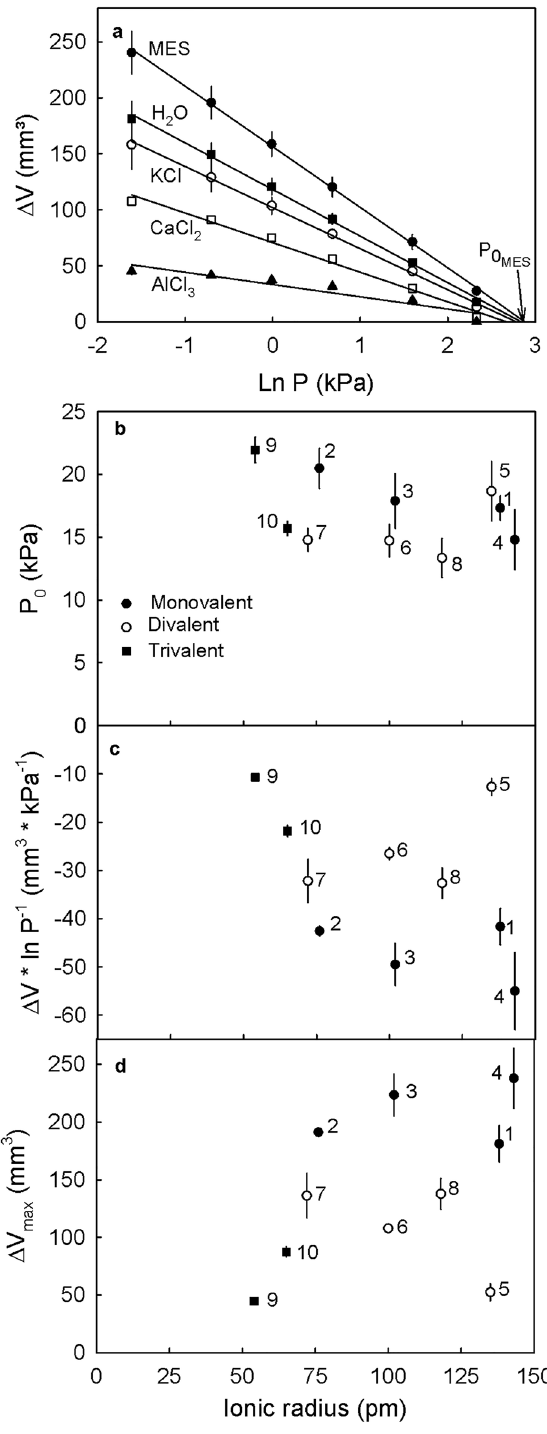
Figure 7. Swelling of cell wall material extracted from ripe ‘Burlat’ sweet cherry fruit when incubated in representative solutions of mono-, di- and trivalent cations. Solutions with monovalent and divalent cations were buffered with 10 mM MES and pH adjusted with KOH or HCl to pH 5.8. Solutions with trivalent cations were unbuffered and pH was measured (Table 9). 10 mM MES and deionized water served as control. Swelling was quantified in vitro as the change in volume (∆V) at different pressures (P) using a custom-built pressure chamber. The ∆V of the swollen cell walls after loading the cell wall with different pressures was quantified. ( a ) Relationship between the swelling of cell walls (∆V) at equilibrium and the natural logarithm of the applied pressure. The swelling pressure P 0 corresponds to the pressure at which no swelling occurs. The value P 0 was estimated as the x-axis intercept of a regression fitted through a plot of ∆V vs. ln P. Each curve represents the mean of three repetitions. ( b ) Swelling pressure P 0 of solutions with different cations depending on the ionic radius of the cation. ( c ) Slope ∆V vs. ln P and maximum swelling of extracted cell walls ( d ) depending on the ionic radius of the cation in the incubation solution. ( b – d ) The numbers next to the data symbols refer to the following cations: KCl (1), LiCl (2), NaCl